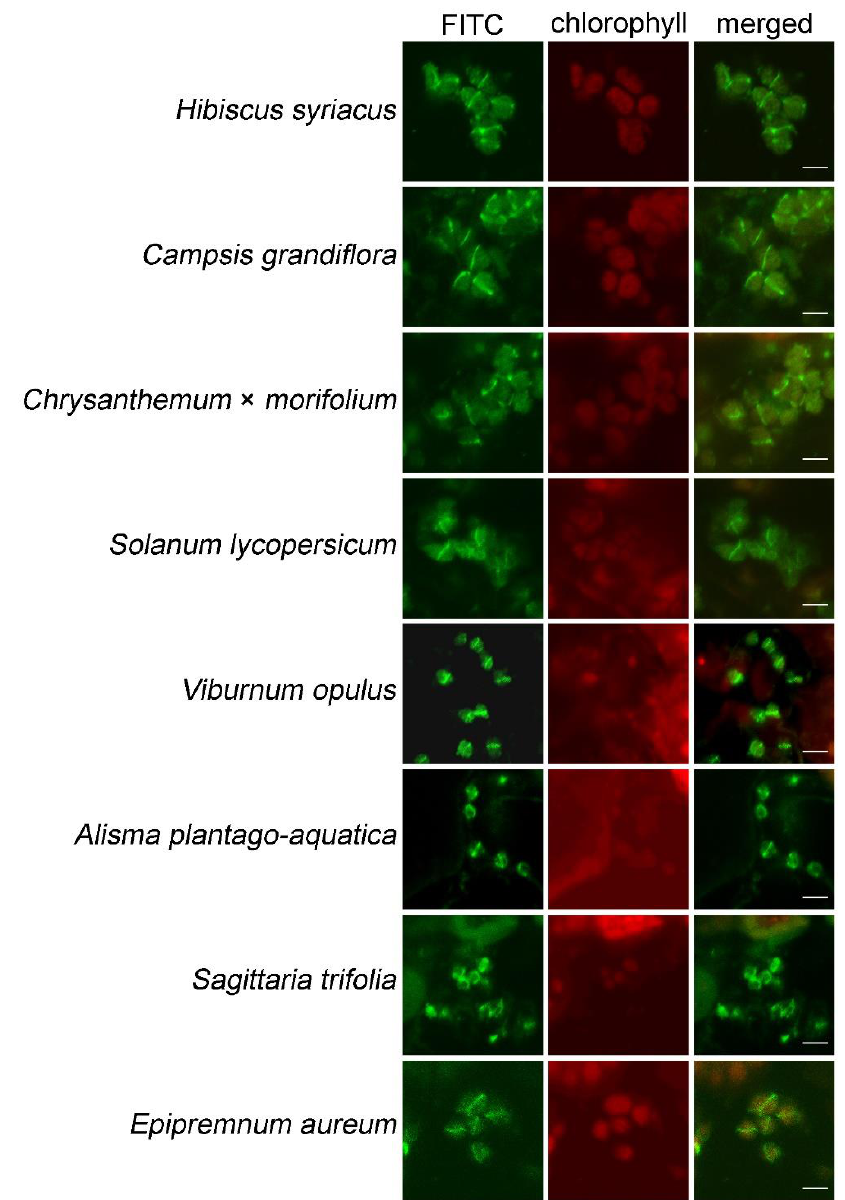
Figure 5. Localization study of FtsZ1 in various plant species with this improved immunofluorescence staining method. Plant species shown are Hibiscus syriacus L., Campsis grandiflora (Thunb.) Schum., Chrysanthemum × morifolium , Solanum lycopersicum L., Viola philippica Cav., Alisma plantago-aquatica L., Sagittaria trifolia subsp. leucopetala (Miquel) Q. F. Wang ‘Florepleno’, Epipremnum aureum (Linden et Andre) Bunting. Bars = 5 μm. Table 1. A list of the plant species in which the signal of FtsZ1 can be observed with this improved immunofluorescence staining method.